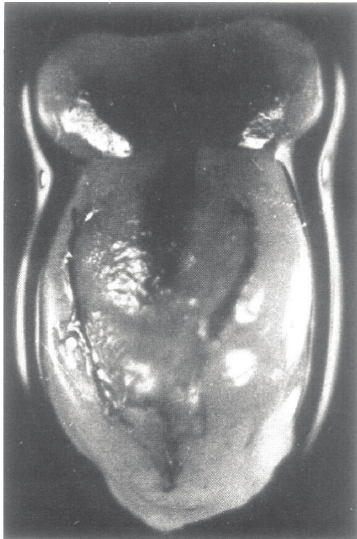
Figure 1: A photograph of a freshly dissected pituitary- hypothalamus complex (PHC) from a normal adult male rat killed 5 minutes, following intracardiac injection of India ink